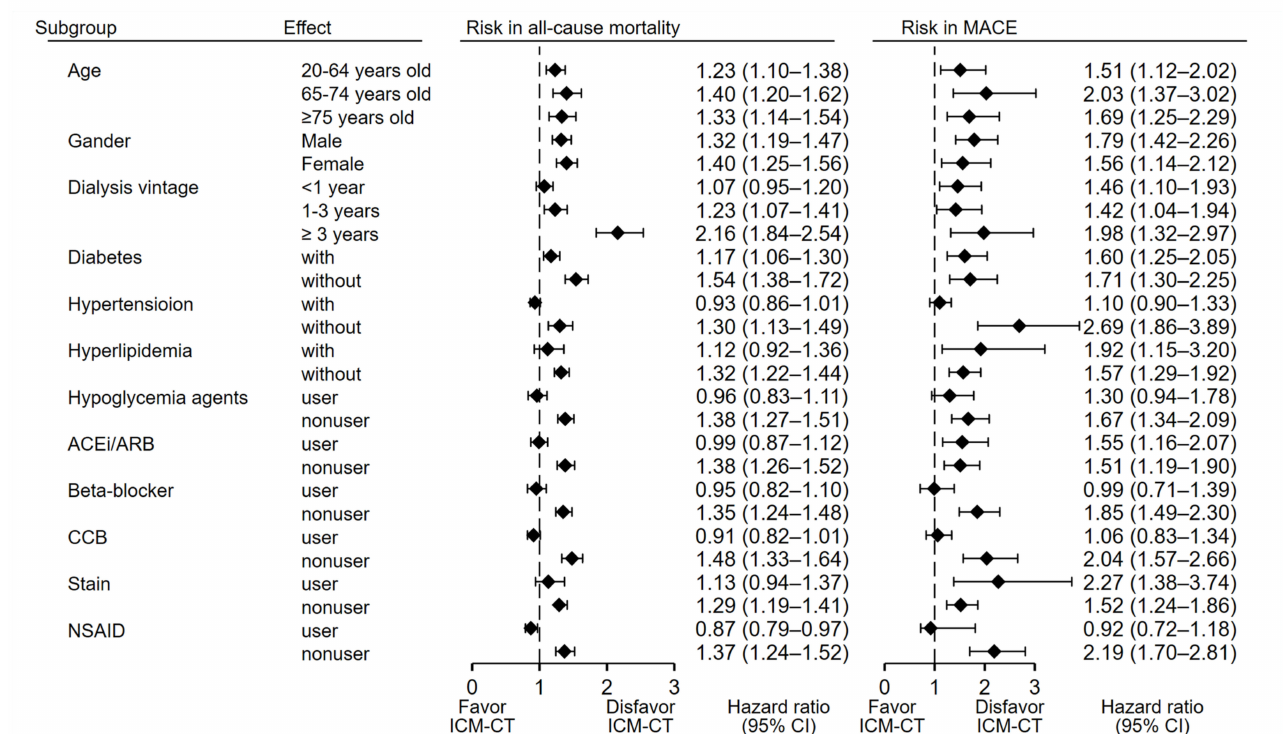
Figure 3. Sensitivity and subgroup analyses of comparative risks for all-cause mortality and major